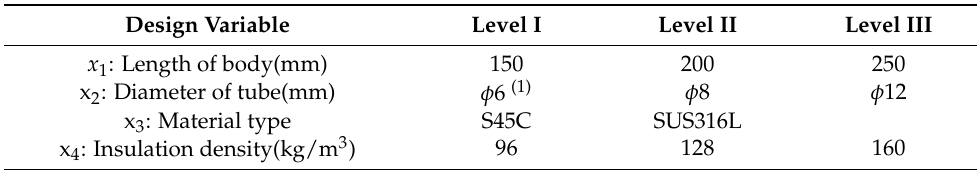
Table 3. Design variables and their levels. Design